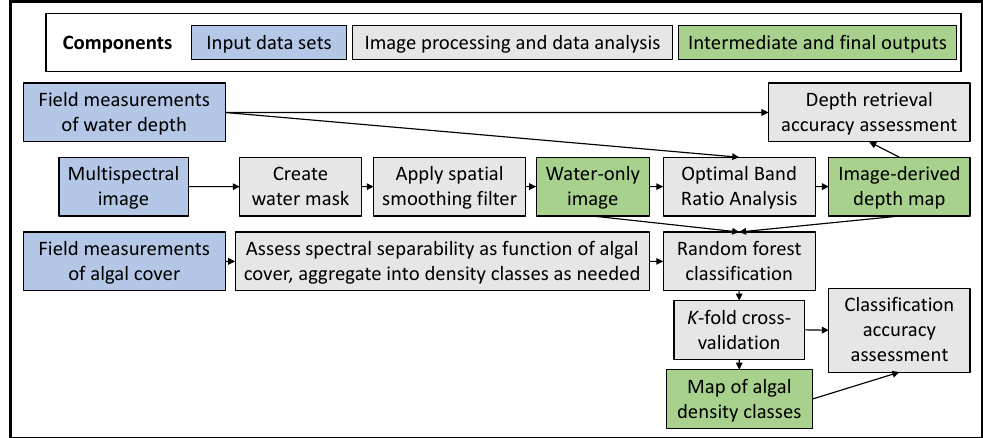
Figure 4. Diagrammatic representation of the workflow for remote sensing of benthic algae in